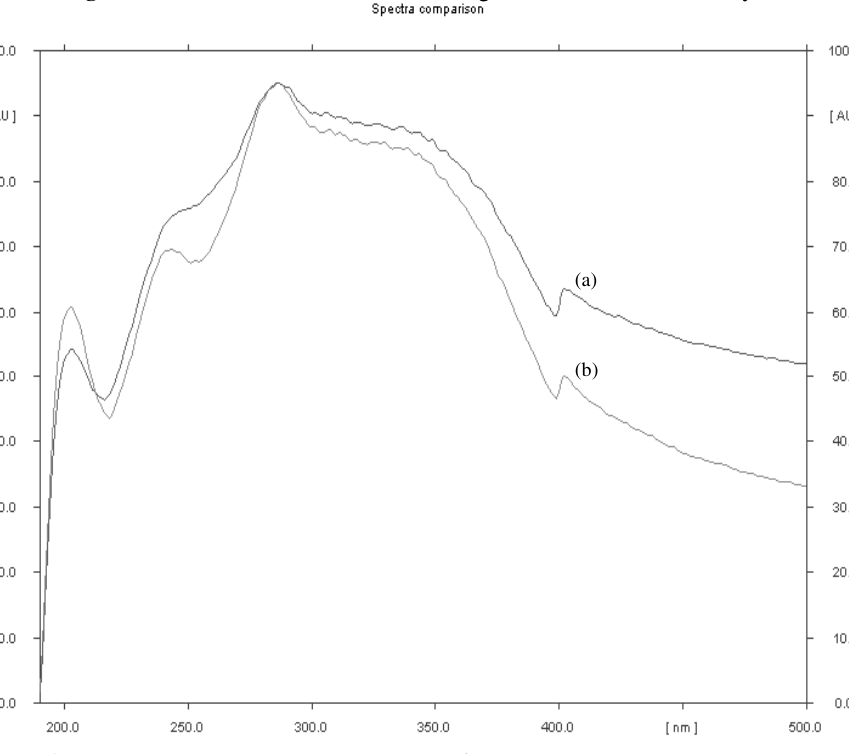
=286 nm and rutin in FFHM; b) λ max